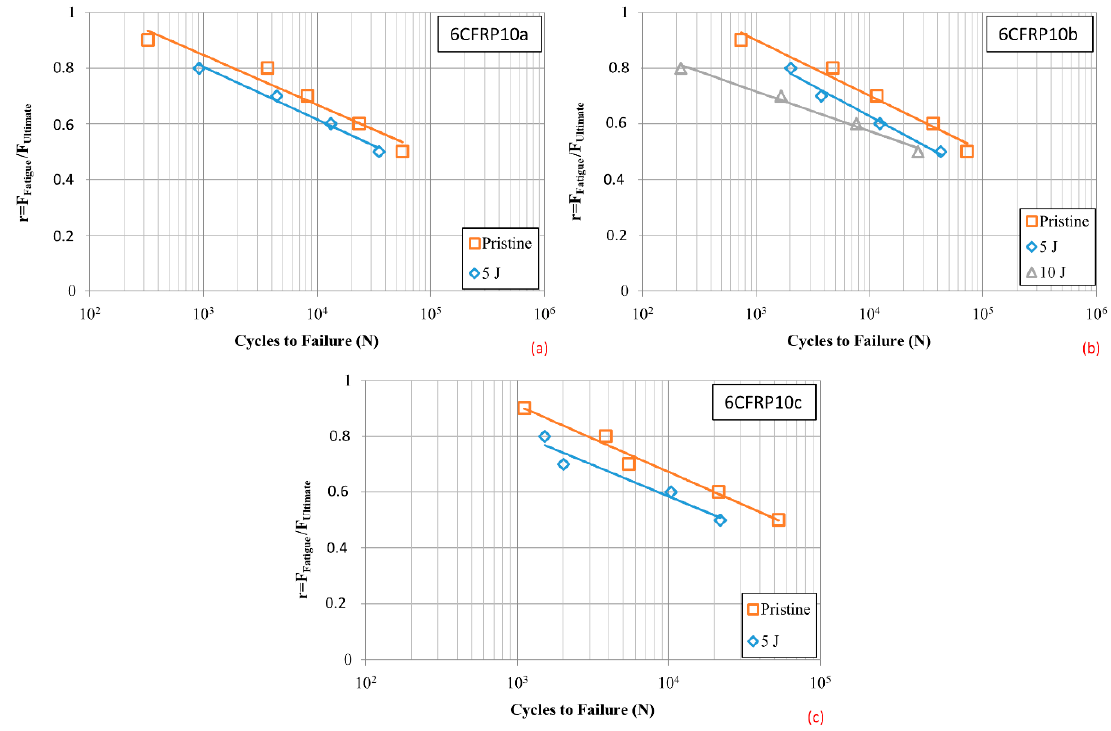
Figure 9. Loading ratio vs. cycles to failure graphs for the ( a ) 6CFRP10a, ( b ) 6CFRP10b and ( c ) 6CFRP10c specimens.